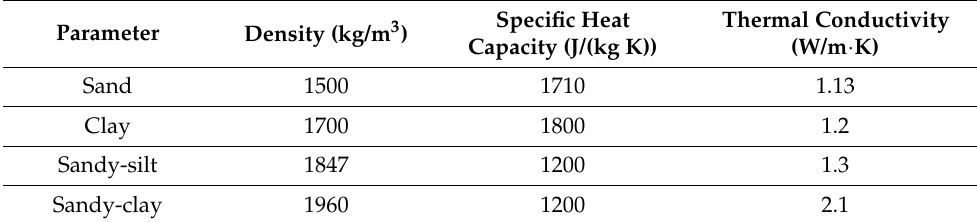
Table 1. Properties of some soil